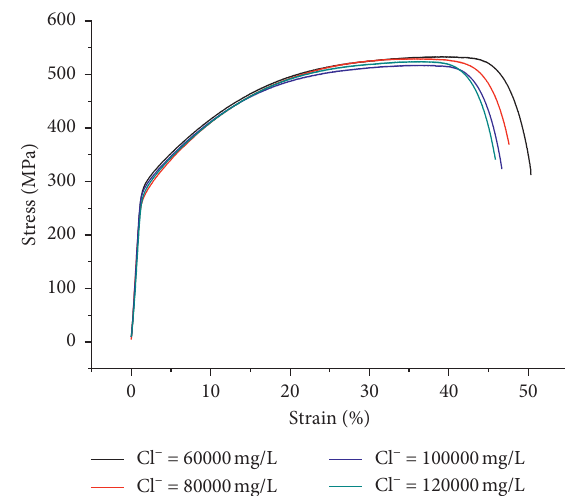
Figure 9: Stress-strain curves of 316L stainless steel at different Cl −